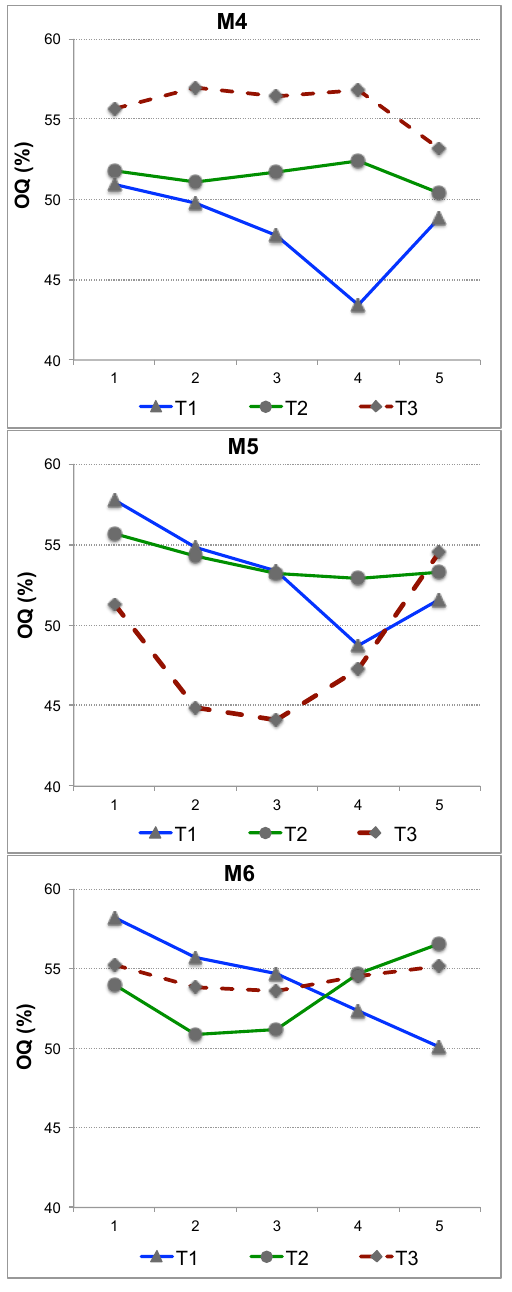
Figure 3 : Averaged OQ contours according to tone T1-­‐3, for the three young male speakers, dashed lines in the ‘muddy’ colour show